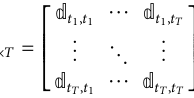
FIGURE 2 Structure of the network and addition of DRO